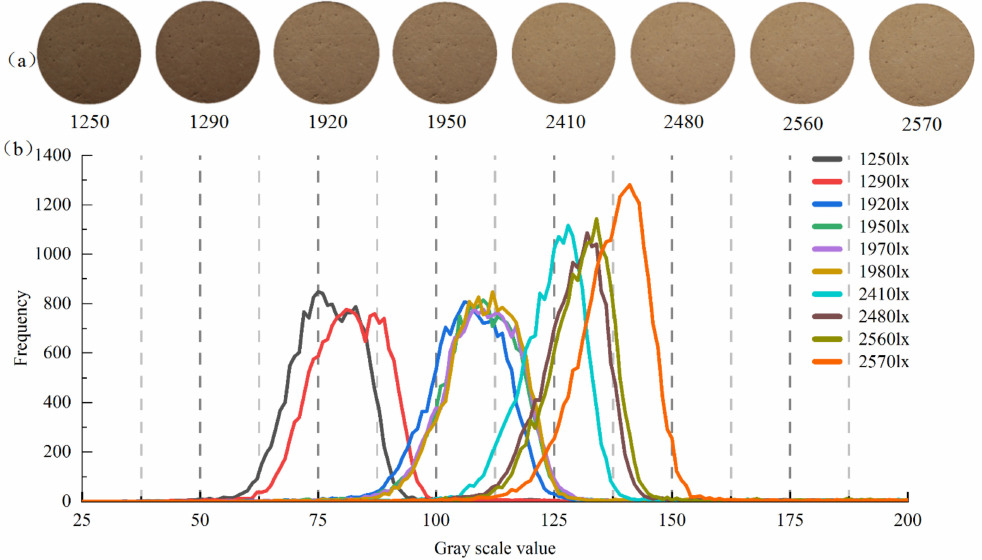
Figure 10. Image and gray scale curve under different illuminance: ( a ) original soil sample images; ( b ) image gray